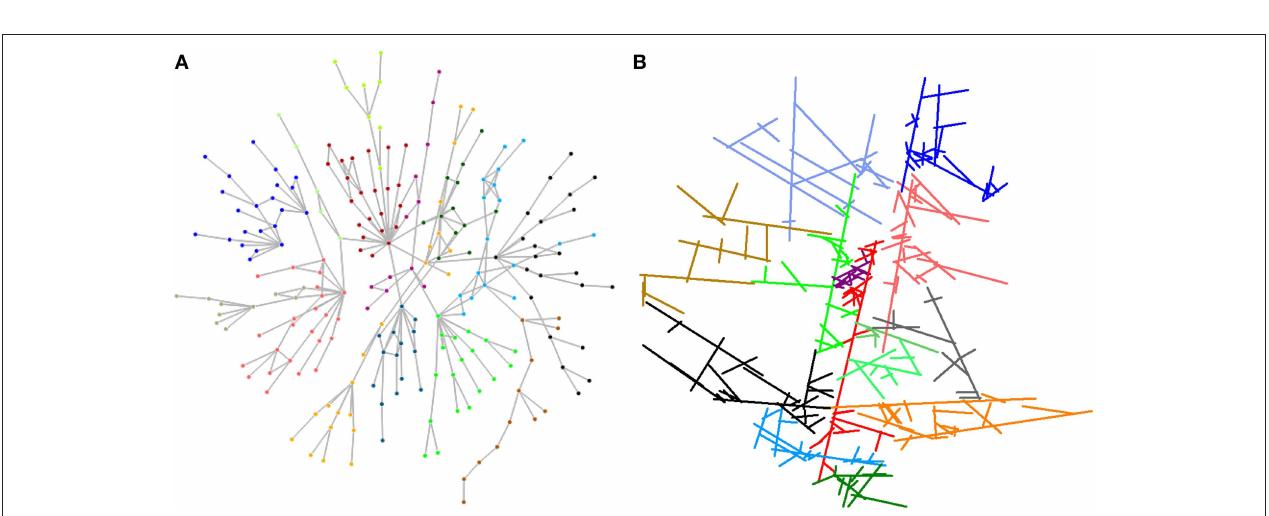
FIGURE 8 | (A) Community structure of the largest component ( r = − 0 . 18 ) of outcrop ASM000026 shows 14 distinct groups. (B) The groups in (A) plotted as they are positioned in the fracture